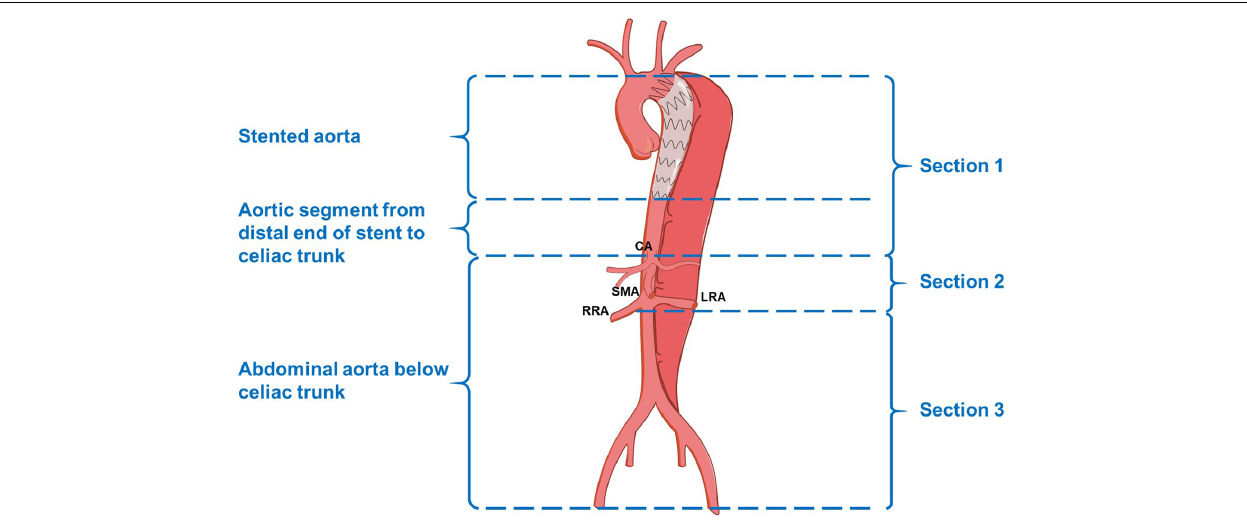
FIGURE 1 | Schematic diagram of the aortic segments and sections. CA, celiac artery; SMA, superior mesenteric artery; RRA, right renal artery; LRA, left renal artery.